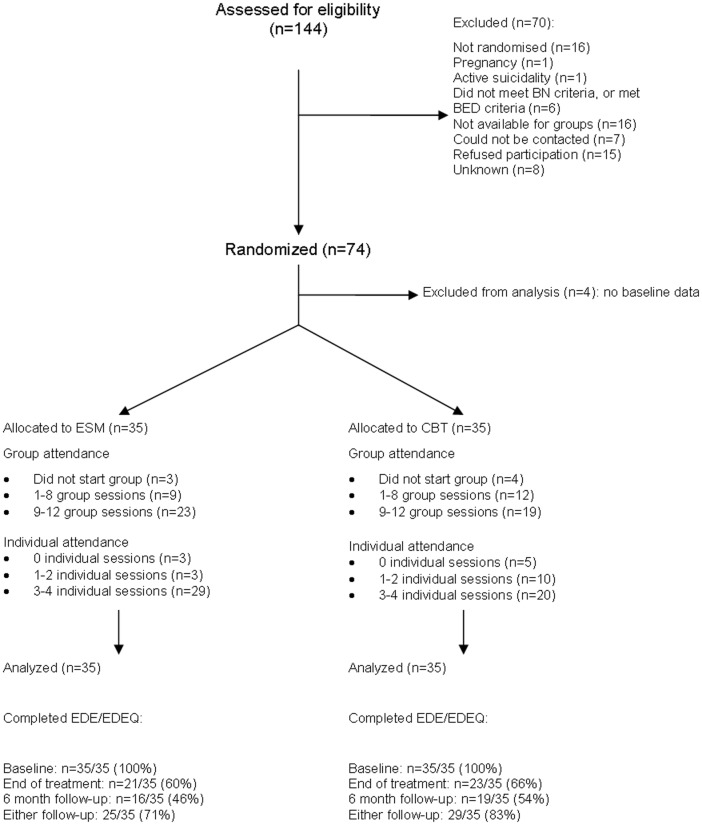
Consort diagram.